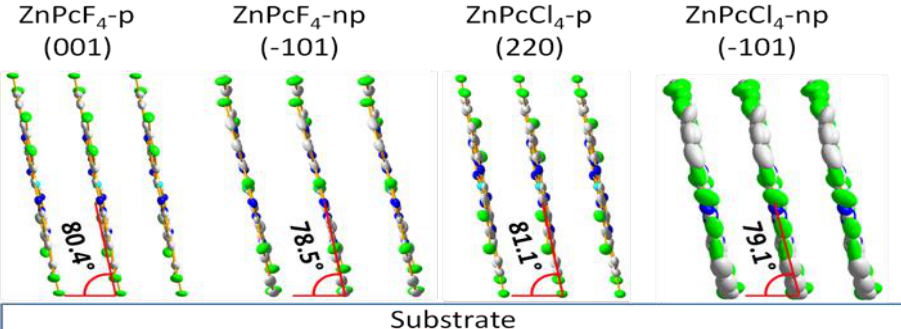
Figure 5. Orientation of ZnPcHal 4 molecules relative to the substrate surface in the films. The morphology of the films was studied by AFM (Figure 6). The morphology of ZnPcF 4 -np and ZnPcF 4 -p films is very similar. The surface of both films consists of slightly elongated crystallites with the size reaching 0.07 μm. The RMS values of ZnPcF 4 -np and ZnPcF 4 -np film are 9.54 and 4.44 nm, respectively. The film of ZnPcCl 4 -p consists of the clearly distinguishable smaller crystallites and has RMS of 5.58 nm. The morphology of the ZnPcCl 4 -p film differs significantly from that of the films of ZnPcCl 4 -p; the film is formed by vague elongated agglomerates, the size of which reaches 0.4 μm. Its RMS value is 8.96 nm.